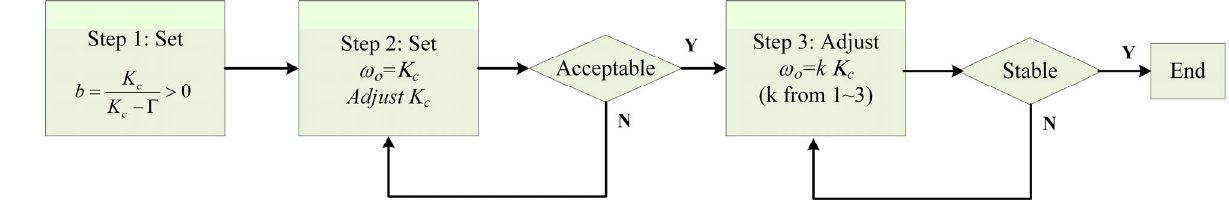
Figure 8. Parameter tuning scheme of LADRC ‐ based magnetic ‐ field measurement method.